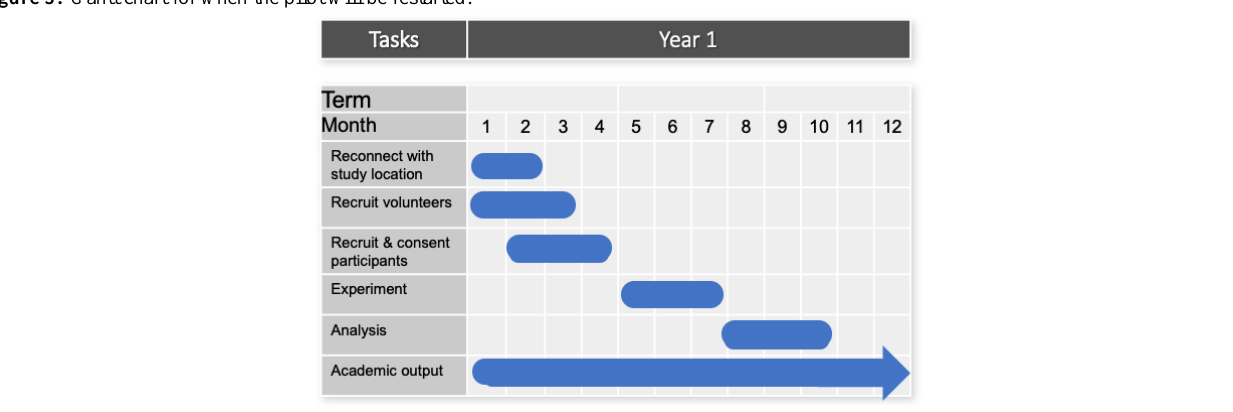
Figure 3. Gantt chart for when the pilot will be